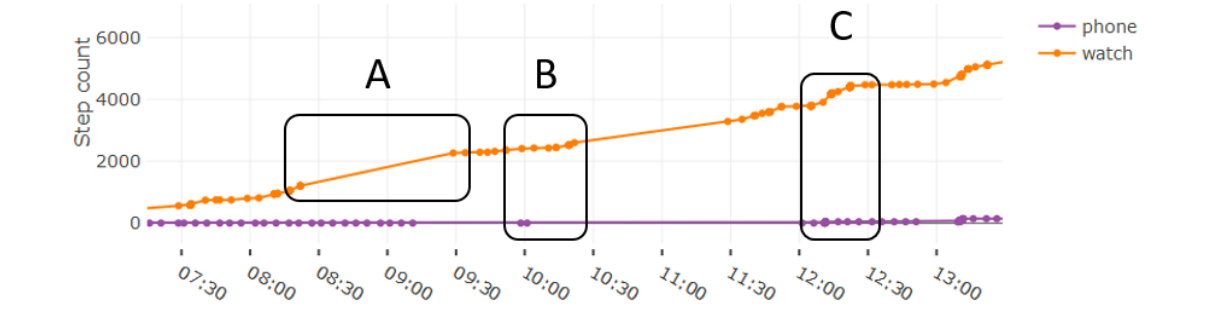
Figure 10. Comparison of step count accumulated over the day between watch and phone. Outlined sections show A) missing updates in watch step